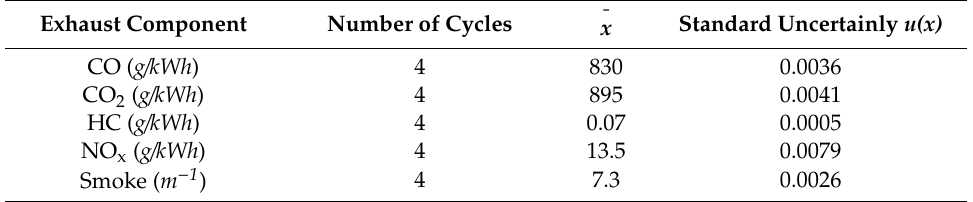
Table 3. Uncertainty ranges u(x) of exhaust components.